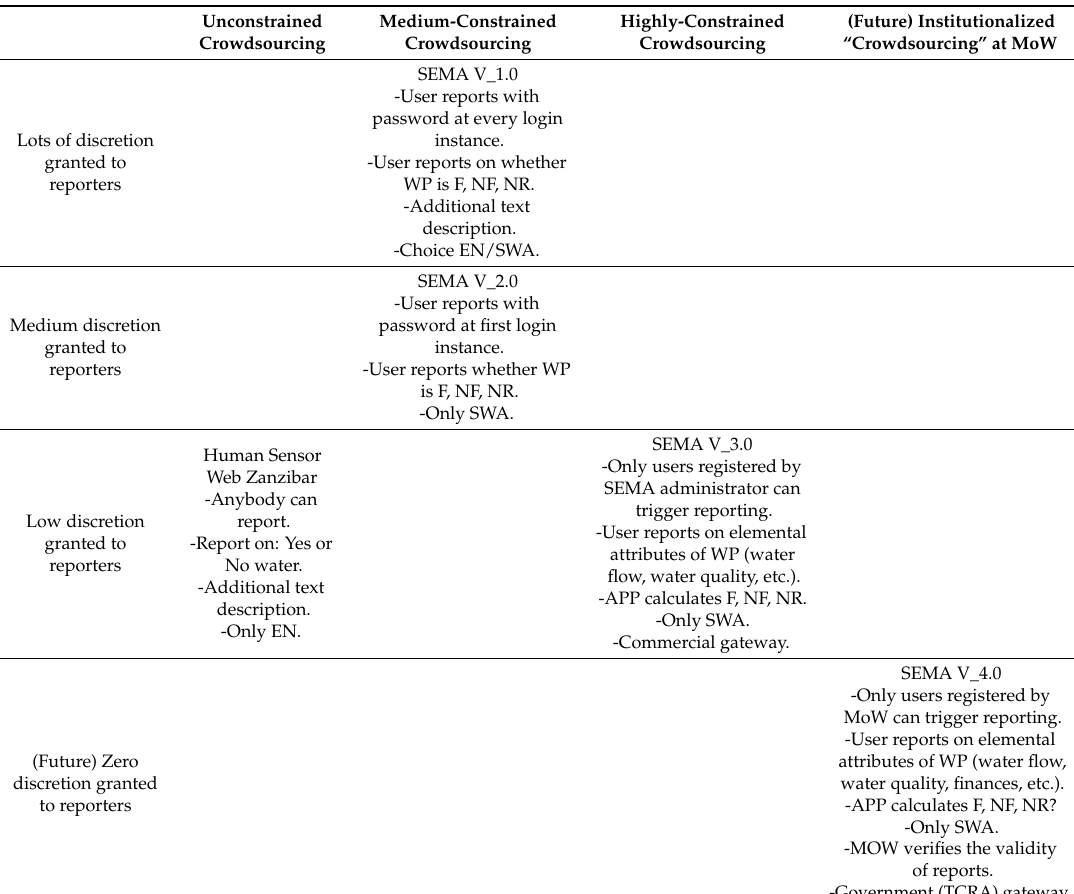
Table 7. Conceptualization of SEMA App